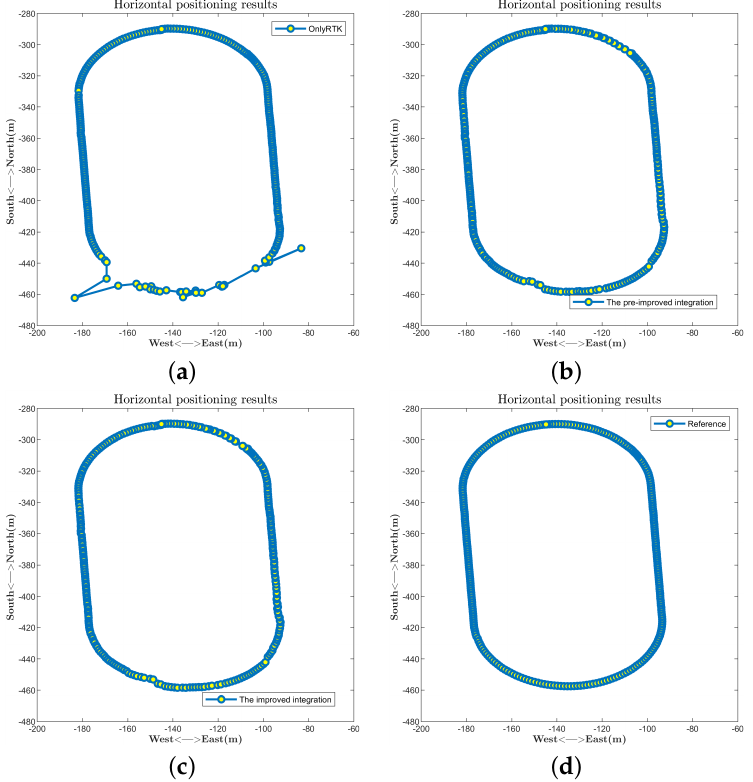
Figure 20. The performances in continuity of different algorithms. ( a ) The valid positioning results of RTK. ( b ) The valid positioning results of the pre-improved integration. ( c ) The valid positioning results of the improved integration. ( d ) The